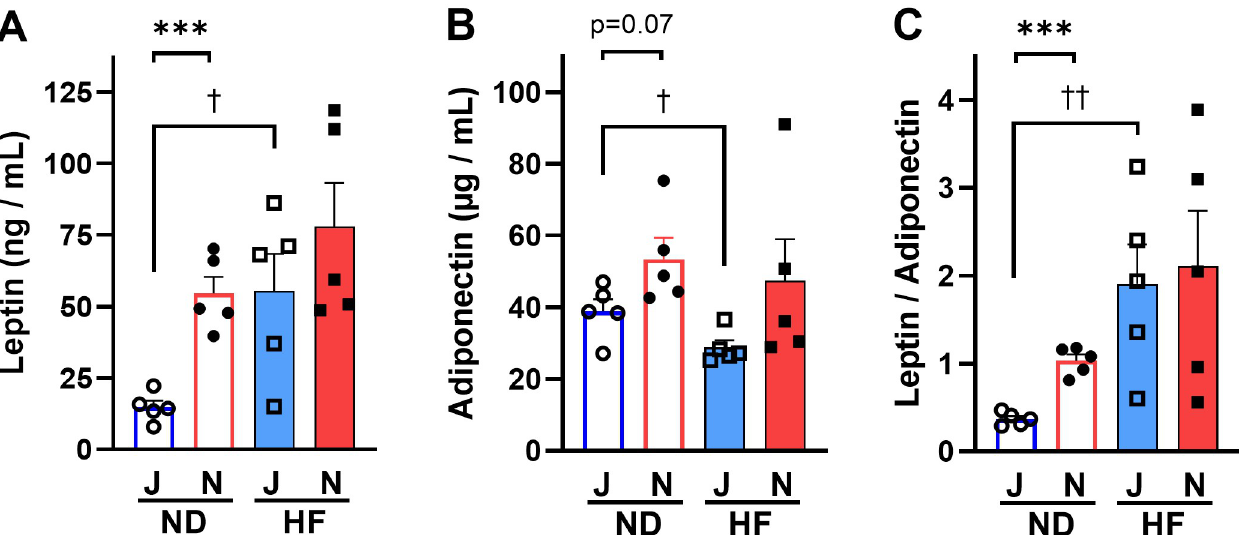
Fig 3. Differences in plasma leptin, adiponectin, and leptin to adiponectin ratio in B6J and B6N mice on ND or HF. (A) Leptin, (B) Adiponectin, (C) Leptin/Adiponectin. Bars are representative of means + SEM (n = 5) for B6J group (blue color) and B6N groups (red color). Two-way ANOVA indicated a significant effect of strain on leptin ( p < 0.01; F = 8.78; Df = 16) and adiponectin ( p < 0.05; F = 5.97; Df = 16) independent of diet, and a significant effect of diet on leptin ( p < 0.01; F = 9.29; Df = 16) and on leptin/adiponectin ( p < 0.01; F = 11.40; Df = 16) independent of strain. Individual means were compared within groups using unpaired Student’s t -test. Asterisks ( � ) and daggers (†) indicate significant differences between B6J and B6N substrain groups and ND and HF diet groups, respectively ( ��� p < 0.001, † p < 0.05, and †† p < 0.01). J, B6J substrain; N, B6N substrain; ND, normal diet, HF, high-fat diet; open circles, ND-fed B6J; filled circles, ND-fed B6N; open squares, HF-fed B6J; filled squares, HF-fed B6N.